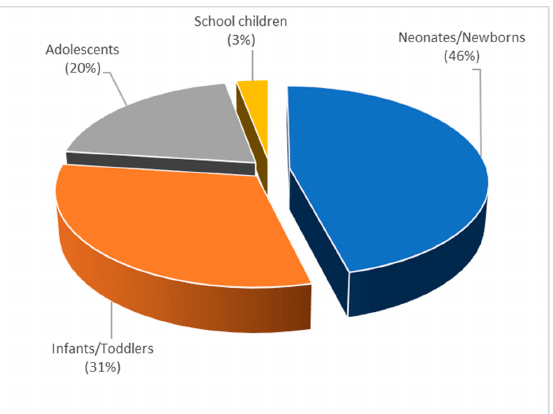
Figure 14. Distribution of published P-PBPK models within topic 3 for different pediatric age groups, expressed as frequency (%), normalized to 100%.